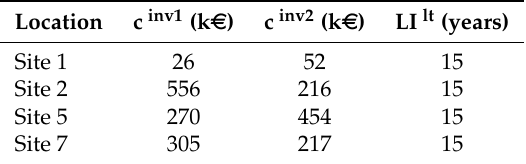
Table 4. Potential heat pumps and their investment parameters.